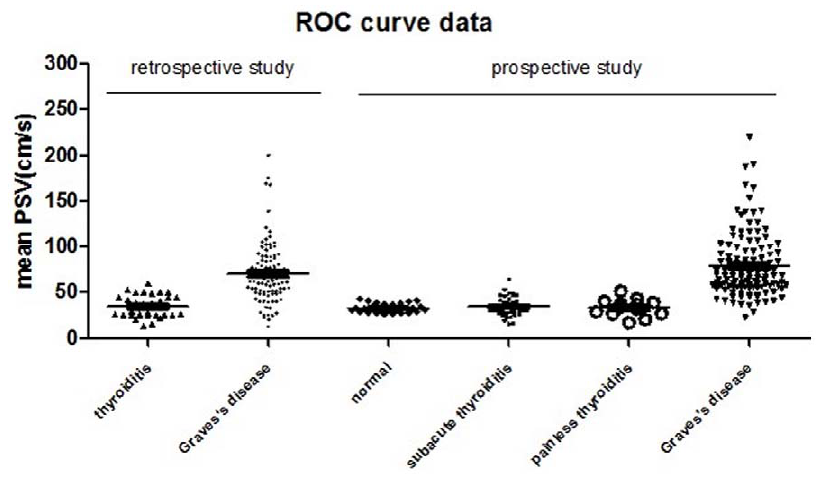
Figure 2. Distribution of mean STA-PSV of normal subjects and patients with thyroiditis and GD.